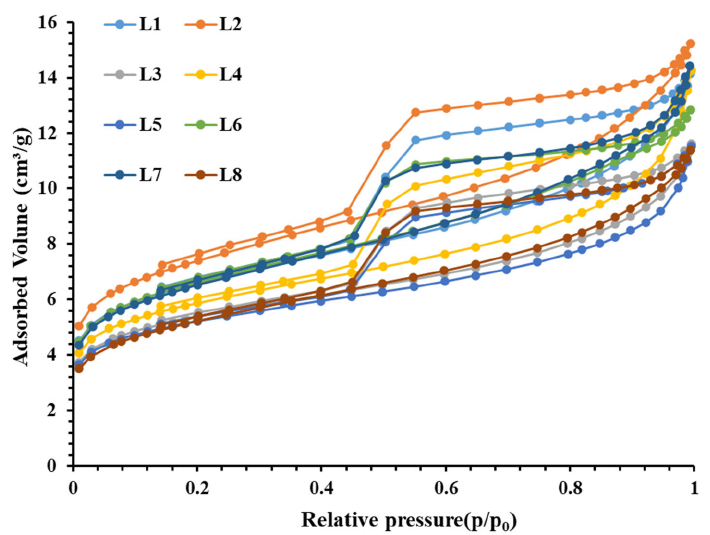
Figure 4. Low ‐ pressure nitrogen adsorption/desorption isotherms of deep shale samples. Figure 4. Low-pressure nitrogen adsorption/desorption isotherms of deep shale